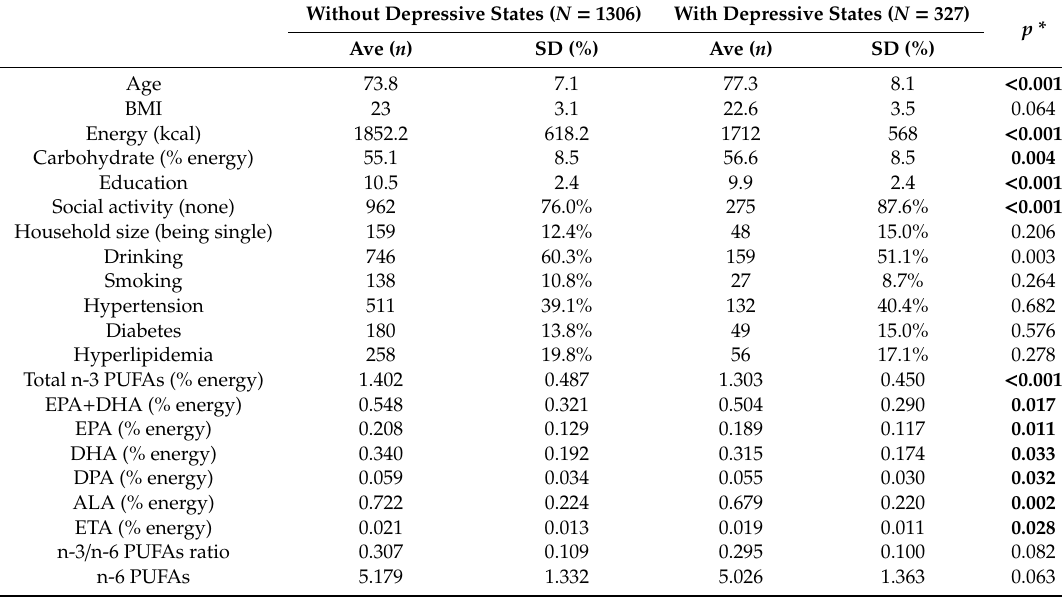
Table 2. Participant characteristics and n-3 polyunsaturated fatty acids (PUFAs) intake according to depressive states ( t -tests and chi-square tests).